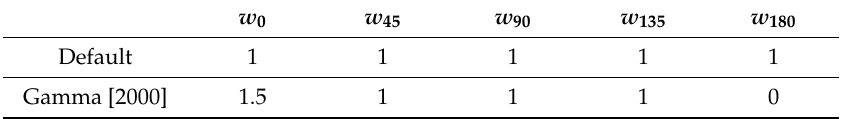
Table 4. Comparison of weights for persistence function in spreading algorithm in Equation